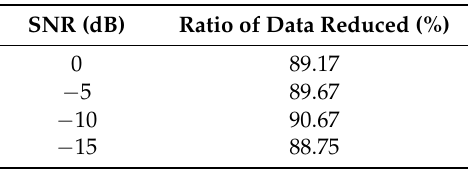
Table 2. The ratio of data reduced in different